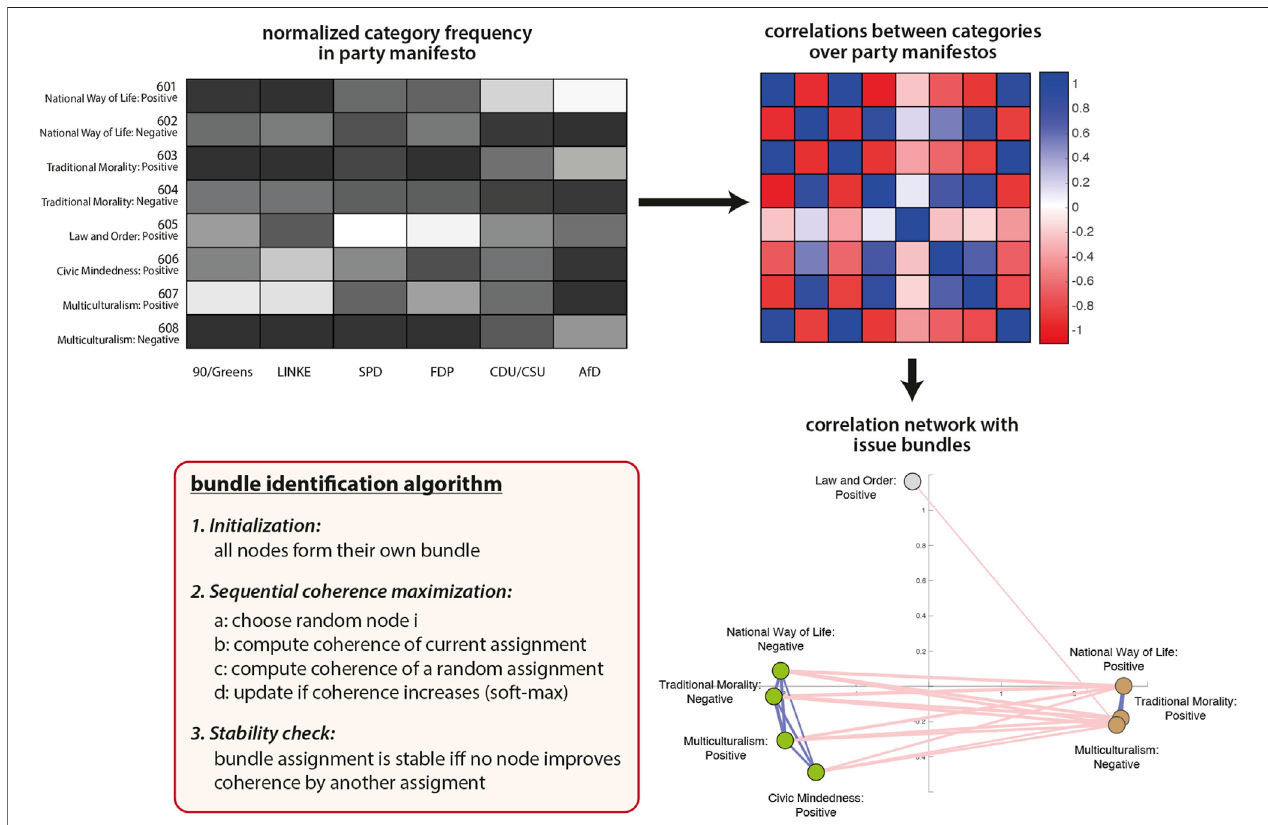
FIGURE 4 | The construction of IICNs and the identi fi cation of issue bundles at the example of the cultural domain (601 – 608) in the German 2017 elections. Startingfromthefrequencywithwhichcategoriesoccurinthemanifestosofthesixparties,inter-issuecorrelationsarecomputed( R )andvisualizedasasignednetwork. Bundles of correlated categories are clearly identi fi able and the pseudo-code for bundle identi fi cation is provided in the red box.